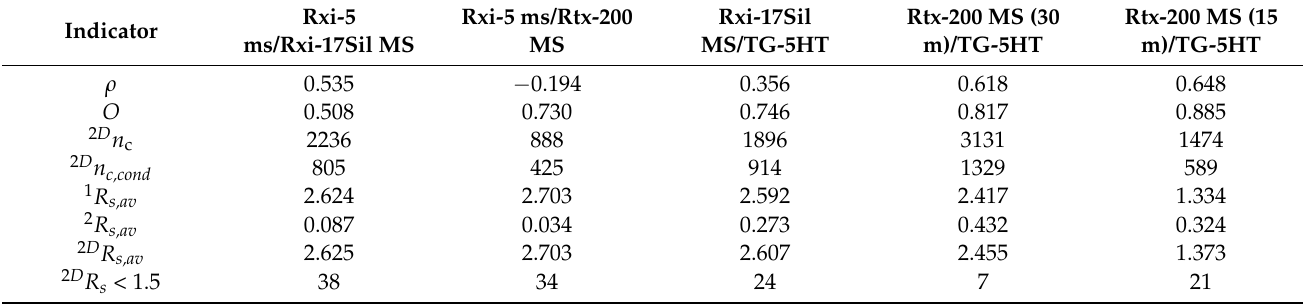
Table 2. The evaluation of orthogonality, use of separation space, peak capacities, average resolutions of individual systems, and the number of coelutions.